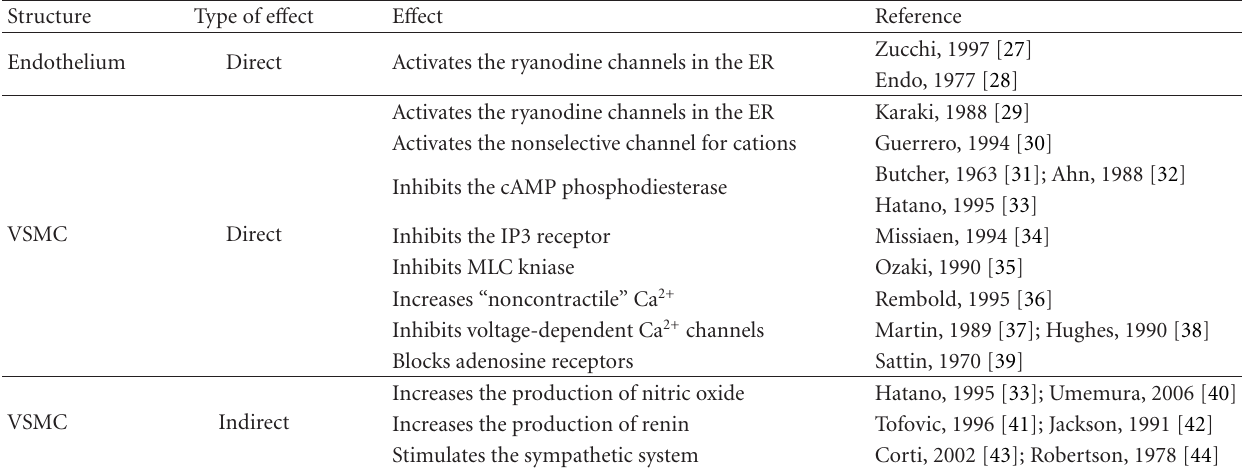
Table 1: Summary of the vascular e ff ects of ca ff